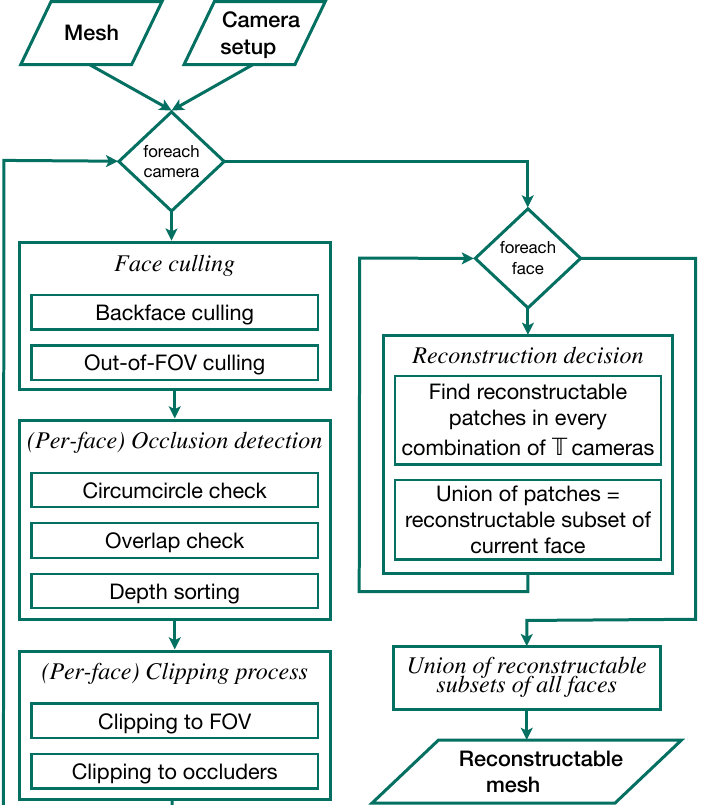
Figure 7. Overview flow chart of the individual steps of the 3D reconstruction simulation. The camera setup and surgical site models comprise the input . The output is the reconstructable subset of the input mesh in